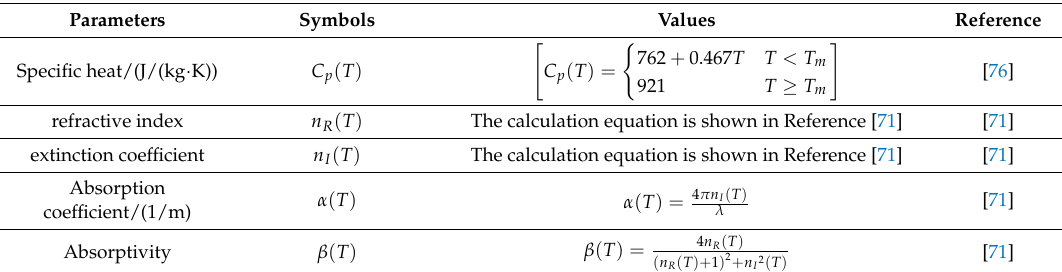
Figure 3. Variation of plasma shielding proportions with laser fluence. 3.2. The Effect of Relaxation Time In this section, the effects of the relaxation time are discussed. The temperature variation in the surface layer of target at different relaxation time is shown in Figure 4 for a laser fluence of 10 J/cm 2 . As can be seen from the figure, the relaxation time has a notable effect on the temperature. The rising time of temperature of surface layer becomes late as the relaxation time increases, and the rising rate of surface layer temperature becomes slow with the increase of relaxation time. At relaxation times of 0.0 s, 1.0 × 10 − 14 s, 1.0 × 10 − 13 s, 1.0 × 10 − 12 s, the time of the surface layer temperature rising to the melting point is 47.2 fs, 51.9 fs, 60.4 fs and 67.3 fs, respectively. When the temperature exceeds the melting point, the surface layer temperature increases exponentially and the growth rate decreases with the increase of the relaxation time. Finally, the temperature of surface layer reaches 0.9 T cr and the phase explosion ablation occurs.